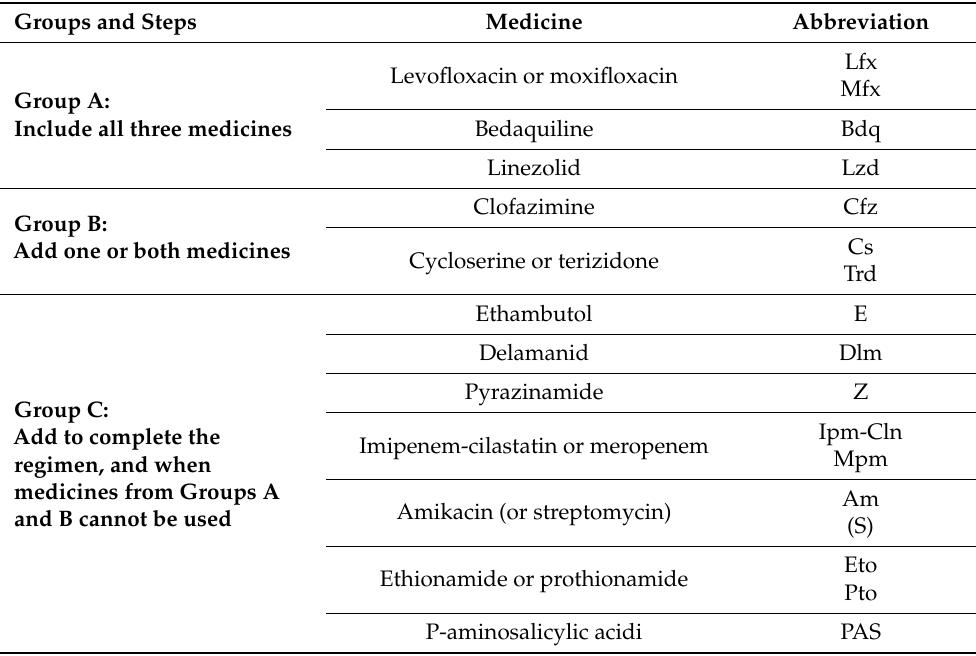
Table 1. The World Health Organization (WHO) groups of multidrug-resistant TB drug.